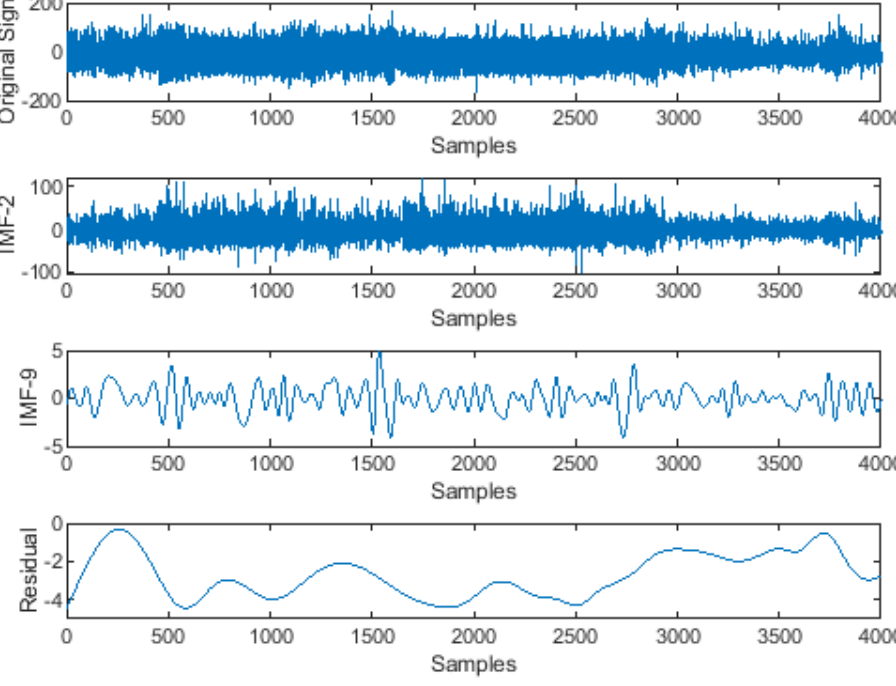
Figure 4. A diagram of an original EEG signal, its different IMFs, and the residual signal after decomposition through the empirical mode decomposition method.